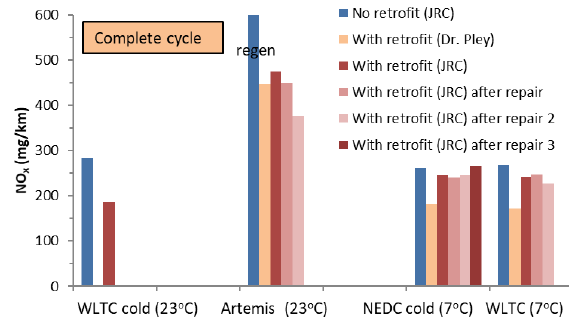
Fig. 6. NO x results for the complete cycles. “Regen” means that regenera- tion took place